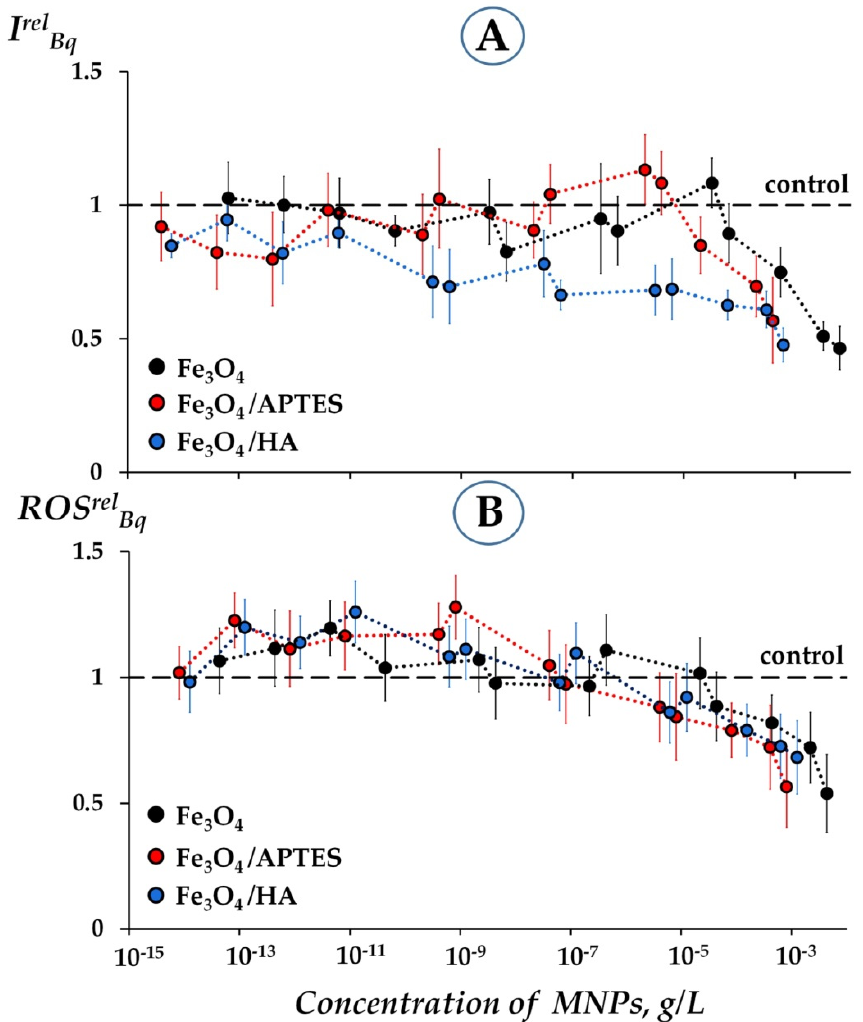
Figure 5. Relative bioluminescence intensity, I relBq , ( A ), and relative ROS content, ROS rel Bq , in the presence of 1,4-benzoquinone (Bq) ( B ) vs. MNP concentration in bacterial suspension under model oxidative stress. The 1,4-benzoquinone concentration was EC 50, Bq = 10 − 7 M (control) with ROS content of 2.7 × 10 − 6 M. Bare Fe 3 O 4 –black circles, Fe 3 O 4 /APTES–red circles, and Fe 3 O 4 /HA–blue circles. (b) Effects of MNPs on ROS Content in Bacterial Suspension under Model Oxidative Stress